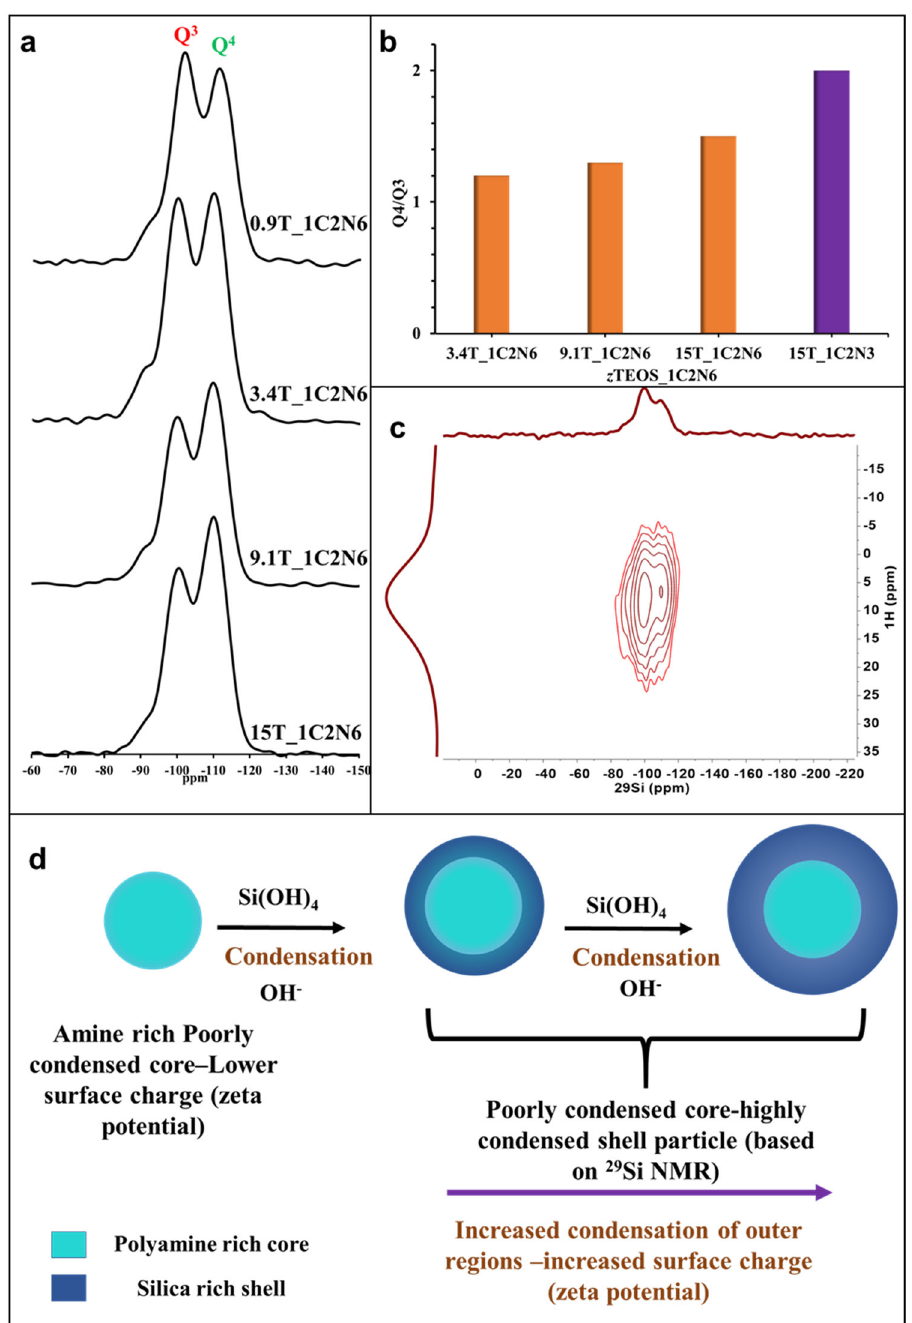
Fig. 5 29 Si Solid State NMR silica particles produced at various z TEOS_1C 2 N 6 mole ratios. a 29 Si Solid state NMR spectra of silica particles produced in presence of 22 mM C 2 N 6 obtained at various mole ratios. b Q 4 / Q 3 ratios of silica particles obtained from deconvolution of 29 Si SSNMR spectra. c 2D 29 Si – 1 H HETCOR NMR with CP contact time of 3 ms of silica particles produced at 15T_1C2N6 mole ratio. d Schematic representation of particles at different stages of